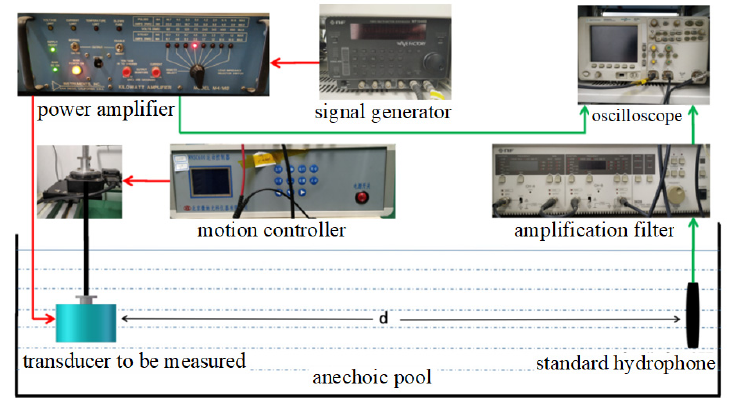
Figure 13. Underwater acoustic transducer test system.